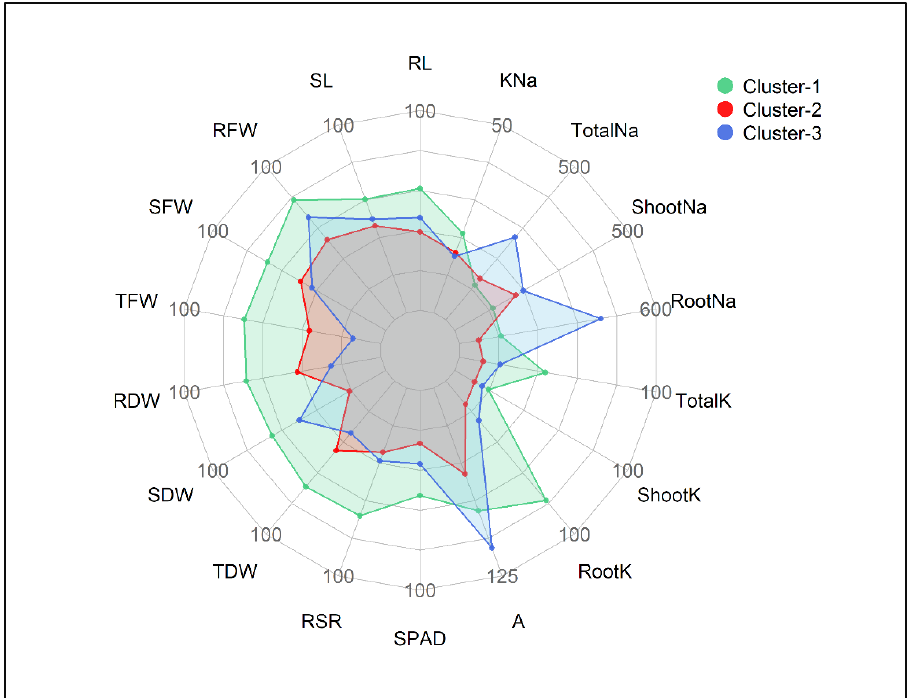
Figure 4. Radar plot showing salt tolerance index (STI) values of different traits in three clusters of 18 maize cultivars. The STI values are expressed as % of the control. The lowest to highest STI scales are 50 to 100 in all traits except K + –Na + ratio (0–50), A (50–125), Shoot and Total Na + (300–500) and Root Na + (300–600), respectively. Units of traits are as follows: RL (Root Length, cm), SL (Shoot Length, cm), RFW (Root Fresh Weight, g), SFW (Shoot Fresh weight, g), TFW (Total Fresh Weight, g), RDW (Root Dry Weight, g), SDW (Shoot Dry Weight, g), TDW (Total Dry Weight, g), RSR (Root–Shoot Ratio), SPAD (Leaf Greenness), A (Photosynthesis rate, µmol CO 2 m −2 s −1 ), RootK (Root K + concentration, mg g −1 DW), ShootK (Shoot K + concentration, mg g −1 DW), TotalK (Total K + concentration, mg g −1 DW), RootNa (Root Na + concentration, mg g −1 DW), ShootNa (Shoot Na + concentration, mg g −1 DW), TotalNa (Total Na + concentration, mg g −1 DW), KNa (K + –Na + Ratio).